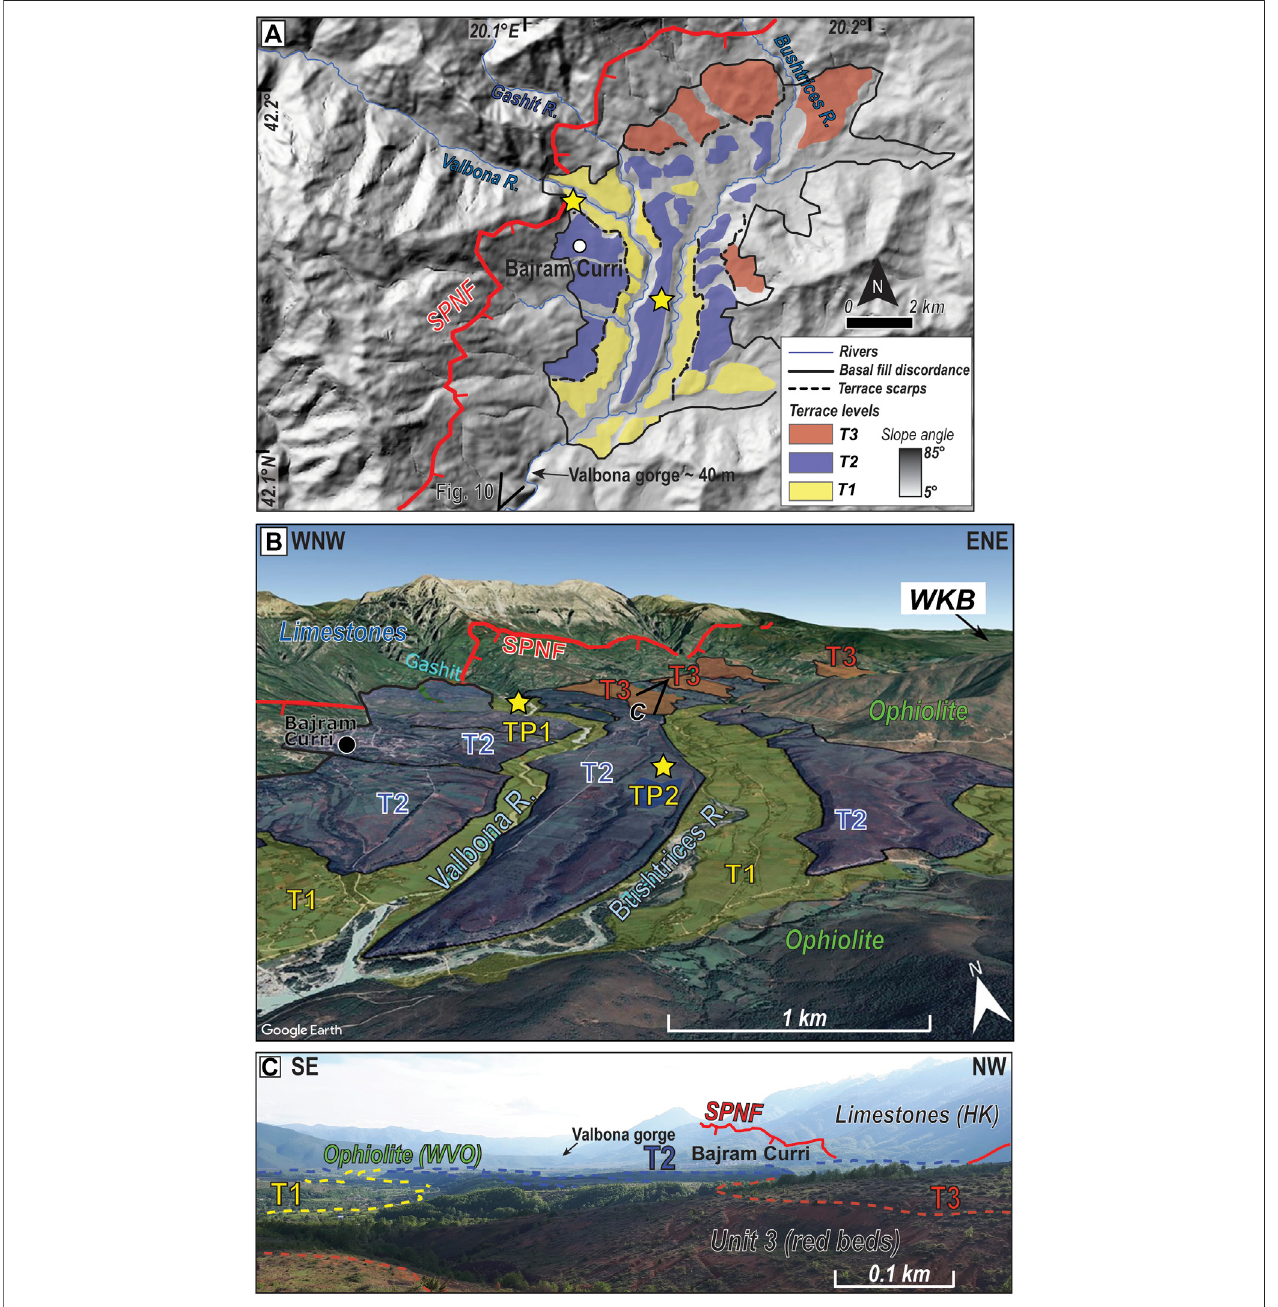
FIGURE 3 | Overview of fl uvial terraces and abandoned river channels documenting episodic incision of the Tropoja Basin (TB) sediments: (A) Map with DEM hill shadingand location of fl uvial terraces. Terracesare numbered from youngest tooldestlevels, T1 to T3. Thick red line – trace ofthe SPNF; Blue – present-day rivers in the TB; (B) Satellite image from Google Earth of the Tropoja Basin showing terrace surfaces coloured according to relative age. Imagery from Google Earth ™ , 42 ° .18 ‘ N, 20 ° 06 ‘ E, 7/01/2021. Yellow stars – location of 36 Cl depth pro fi les; (C) Pleistocene-Holocene fl uvial terraces. Note hummocky “ terra rossa ” (red beds) of Unit 3 (foreground) and the high relief of the Albanian Alps (background right) in the footwall of the SPNF. WVO – Western Vardar Ophiolite; HK - High Karst Nappe.